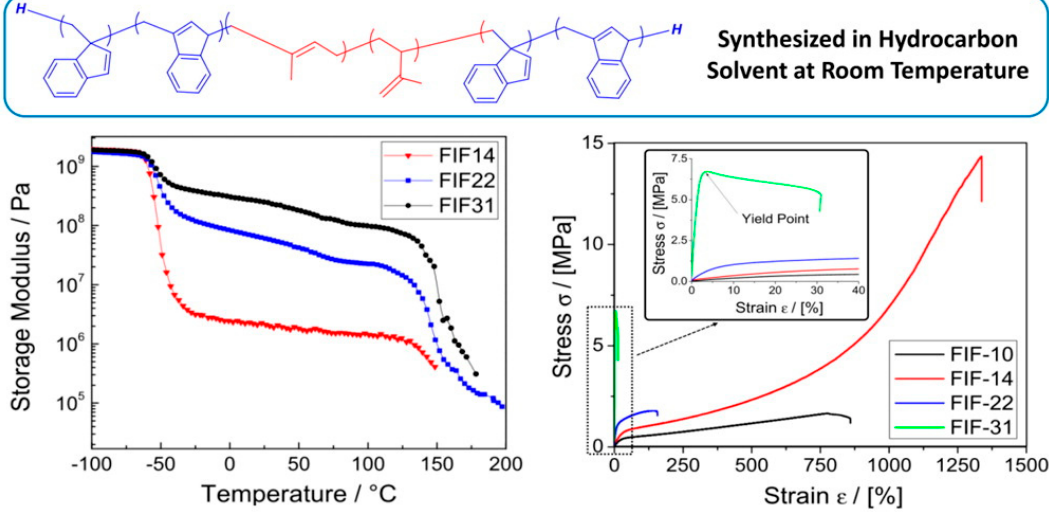
Figure 15. The structure of poly(benzofulvene (BF)- b -isoprene- b -benzofulvene) (FIF) block copolymer and mechanical analysis. Reprinted from Reference [92]. (Copyright (2016) American Chemical Society).